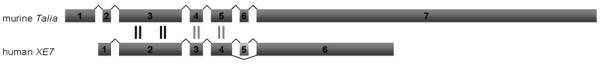
Comparison of the exon structure and homology of mouse Talia with human XE7. Homology between exons is indicated by dashed vertical bars, with the highest sequence conservation between exon 3 of Talia and exon 2 of XE7 (darker bars). Two splice variants have been demonstrated for XE7, as indicated. The inclusion of exon 5, which contains two in-frame stop codons, is predicted to result in a truncated protein [23]. (Relative scaling of exon sizes are only approximate.)